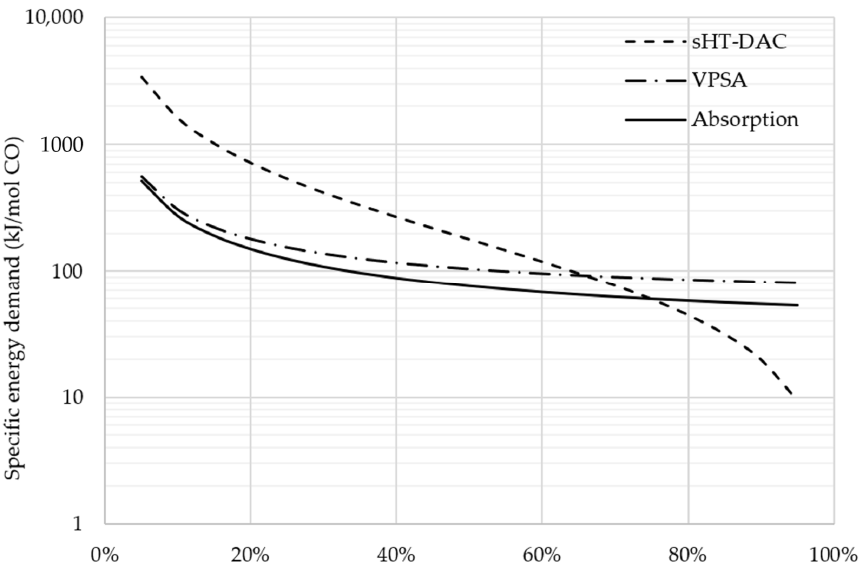
Figure 7. Comparison of the energetic needs required by different CO/CO 2 separation techniques. Electricity has been converted into heat assuming that it is supplied by a Rankine cycle with a 40% efficiency. The acronym VPSA stands for vacuum-pressure swing absorption. To produce the target vacuum of 5 × 10 −4 bar, a system composed of two stages of steam jets and a liquid ring pump is used. The steam is produced at 13 bar using the waste